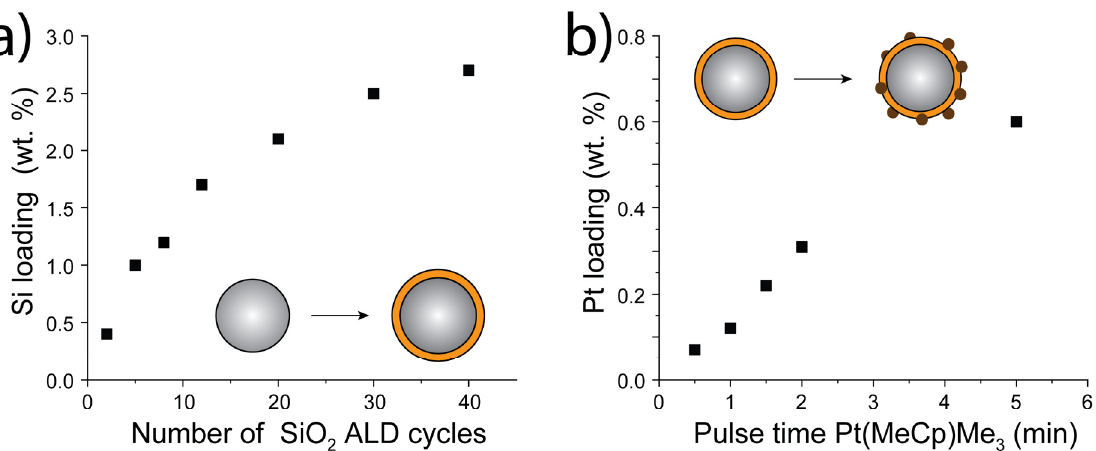
Figure 1. ( a ) Development of the Si loading with the number of applied SiO 2 ALD cycles on TiO 2 (P25) particles, ( b ) Development of the Pt loading with the Pt precursor pulse time (MeCpPtMe 3 ) on SiO 2 coated TiO 2 (P25) particles (2.1 ± 0.2 wt. % Si).